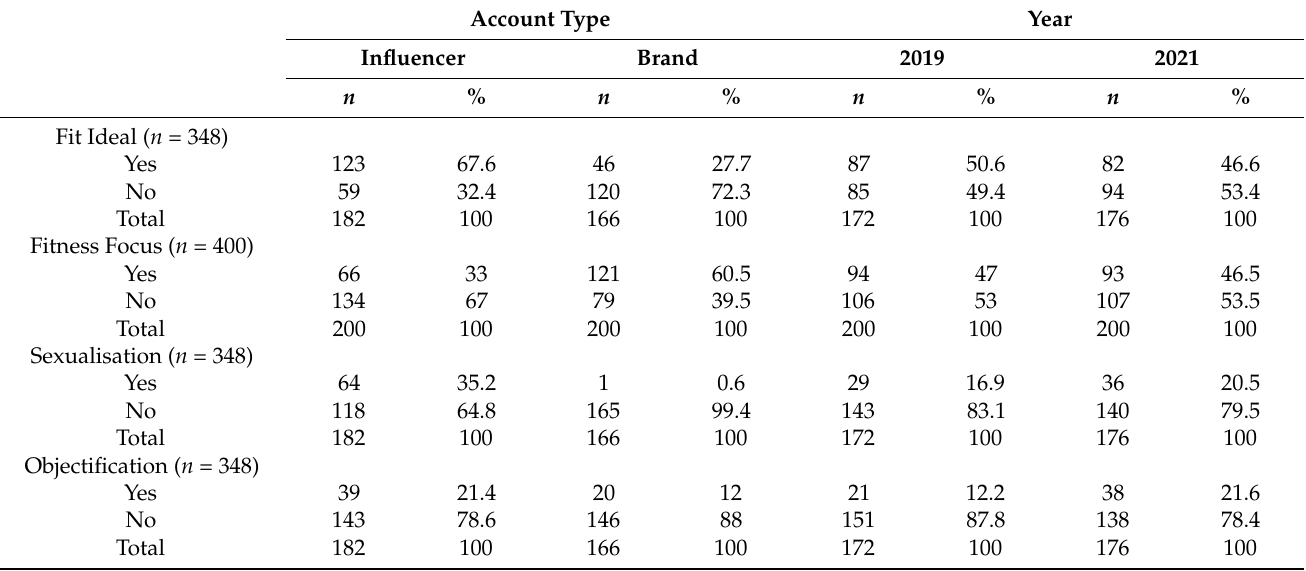
Table 1. Distribution of Fit Ideal, Fitness Focus, Sexualisation, and Objectification in Images by Account Type and